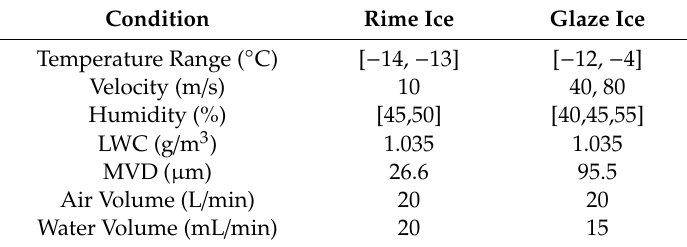
Table 2. Icing flow conditions.